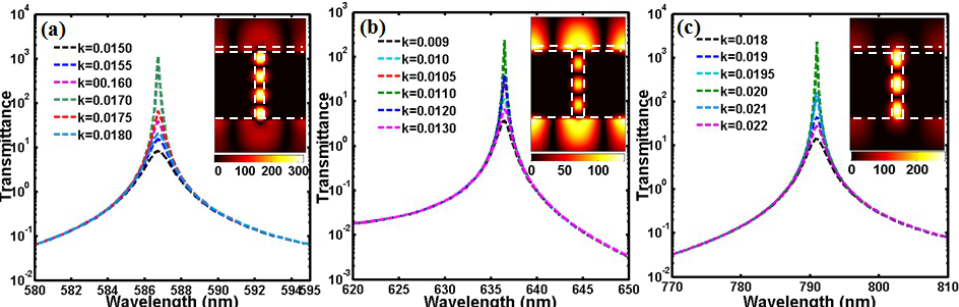
Fig. 6. Transmittance spectra of different gain values assisted nanoslit array for λ 1 − λ 3 , respectively. The inset in (a)–(c) show the enhanced magnetic field distributions of the structure at corresponding gain threshold for λ 1 − λ 3 .